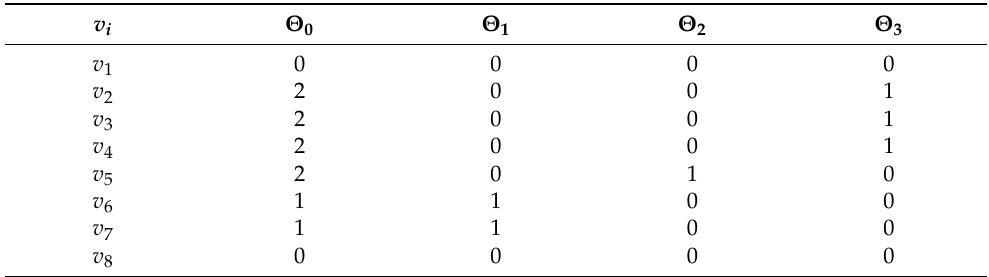
Figure 6. Embedding nodes of graph G in Figure 1 using features in Section 3.6. Table 5. Vertex orbits of pattern order 3 counting of induced graph of relation 3 (i.e., work relationship) of data graph Figure